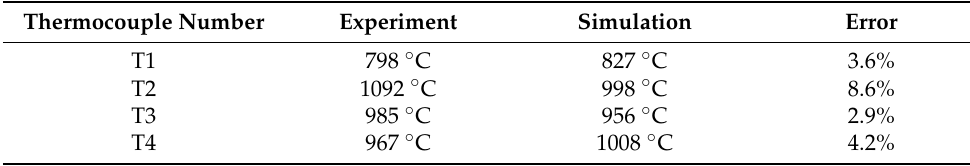
Table 3. Comparison of experimental and numerical simulation